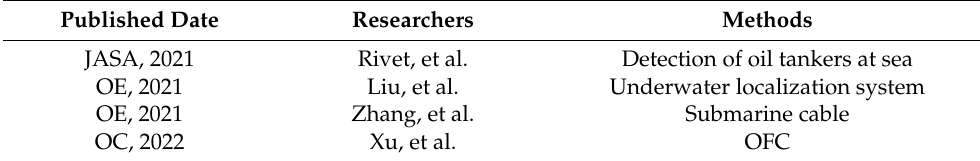
Table 10. Summary of underwater positioning applications.